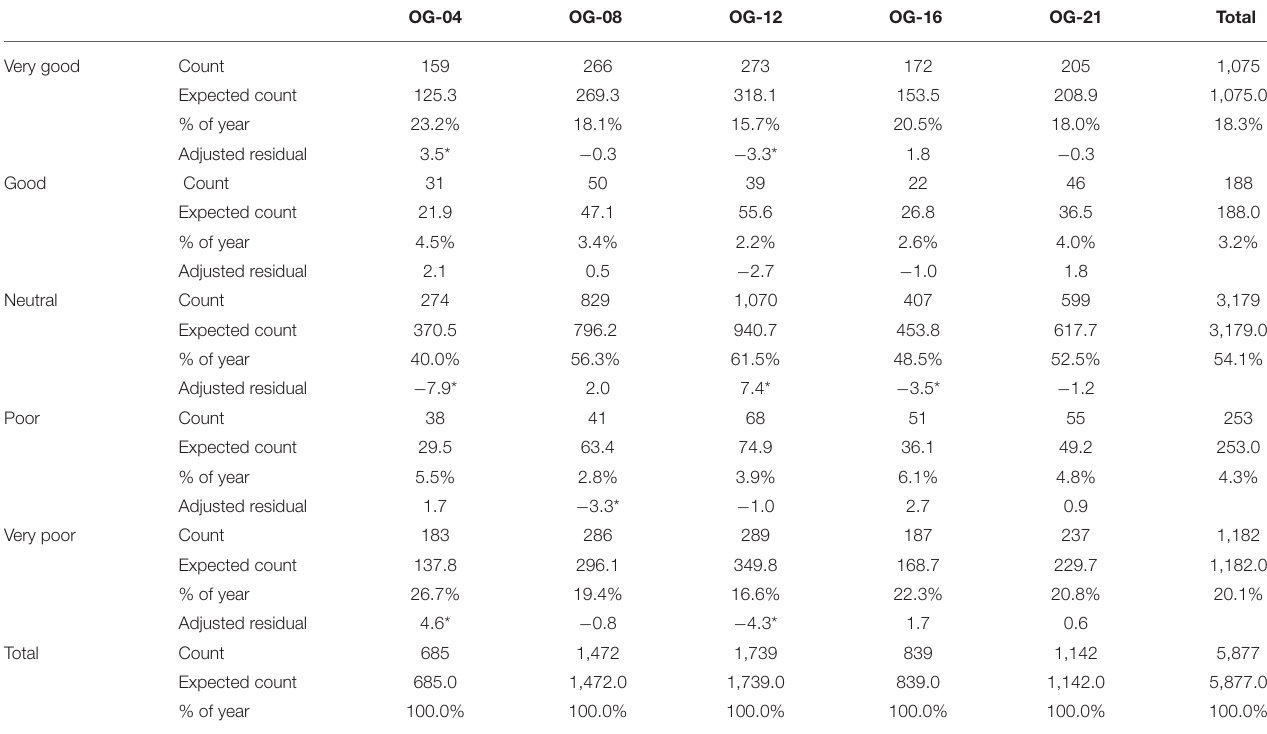
TABLE 4 | The distribution of stroke efficacy throughout the different Olympic Games from 2004 to